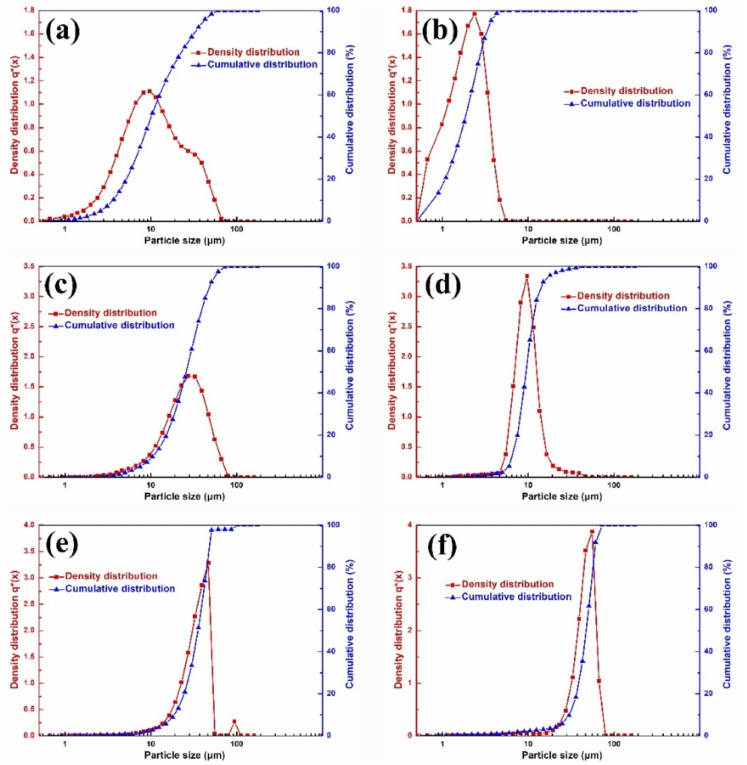
Figure 2. Particle size distribution of commercial ( a ) 3, ( c ) 8, and ( e ) 20 µ m and jet-milled ( b ) 3, ( d ) 8, and ( f ) 20 µ m W